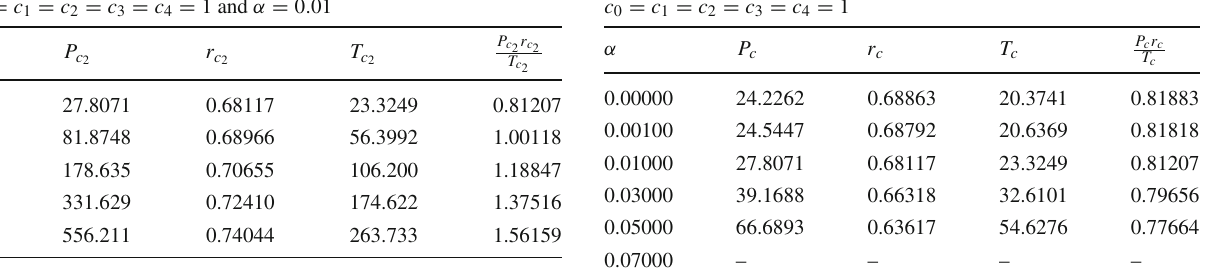
Table 8 (Cold) Hyperbolic black holes: k = − 1, q = 1, m = 1, Table 10 Hyperbolic black holes: k = − 1, d = 7, q = 1, m = 1, and